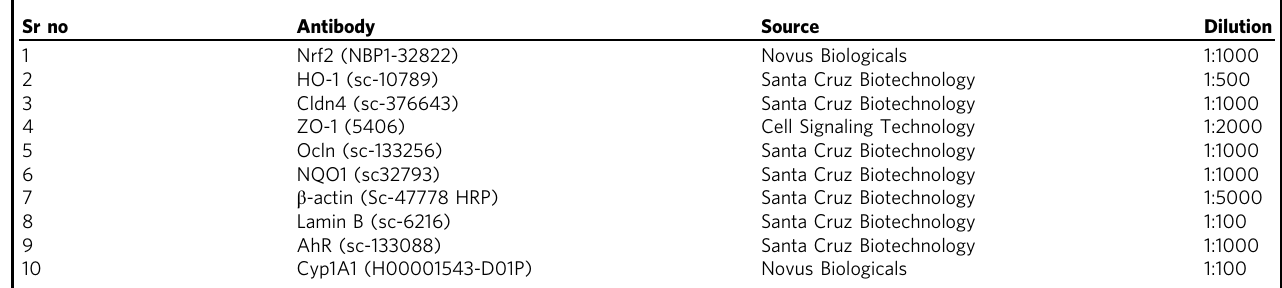
Table 1 List of antibodies used for western blots Sr no